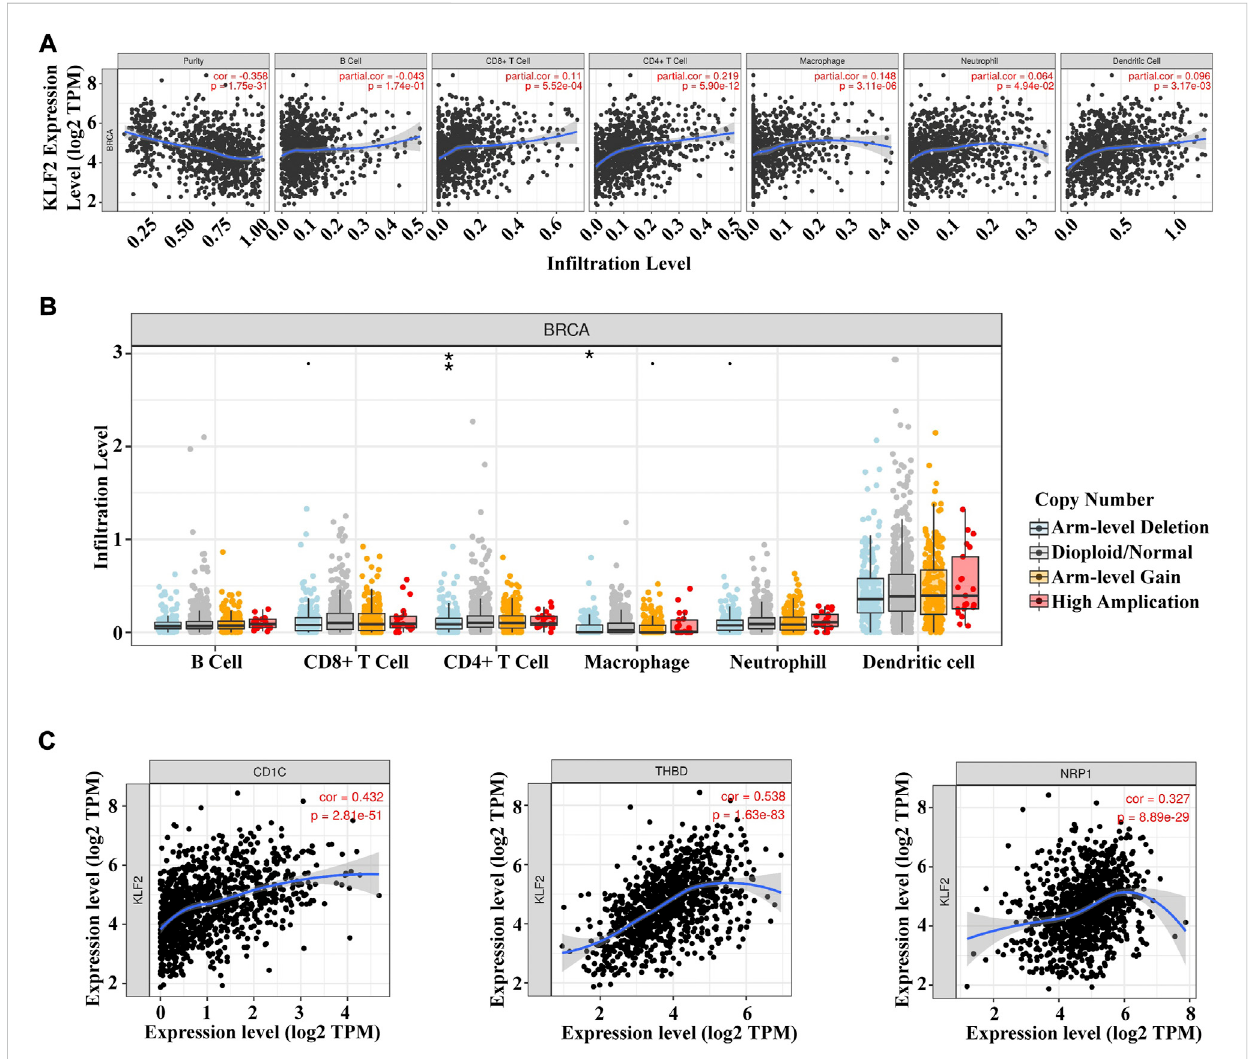
FIGURE 5 Relationships between KLF2 and tumor immune in fi ltrating cells. (A) Association between the expression level of KLF2 and immune in fi ltration cells inbreastcancer. (B) KLF2CNVaffectsthein fi ltratinglevelsofBcell,CD8 + Tcell,CD4 + Tcellmacrophages,neutrophils,anddendriticcellinbreastcancer. (C) The correlation between KLF2 expression and dendritic cells in breast cancer. p , p < 0.05; pp , p < 0.01; ppp , p < 0.001; ns, no signi fi cant.